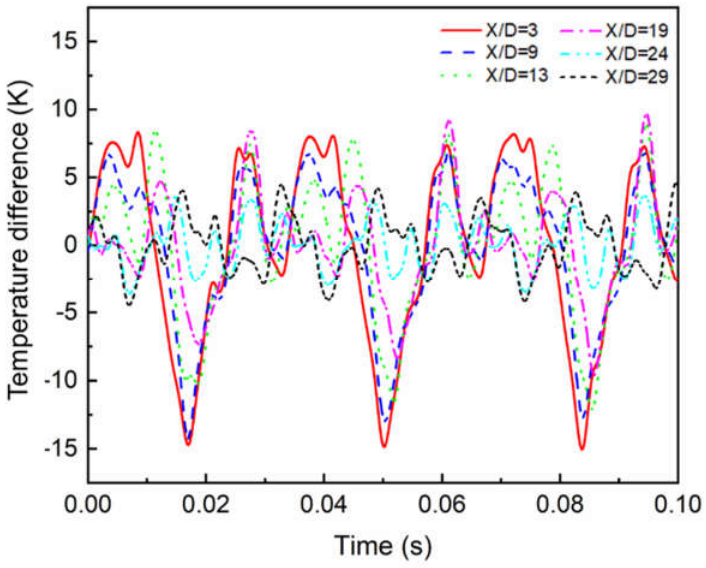
Figure 15. Temperature difference from the time average temperature of the different cross-sections of the “PS”.